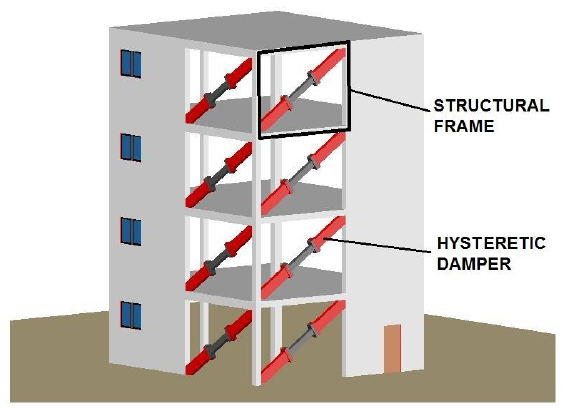
Figure 1. Basic configuration of a building structure with dampers.